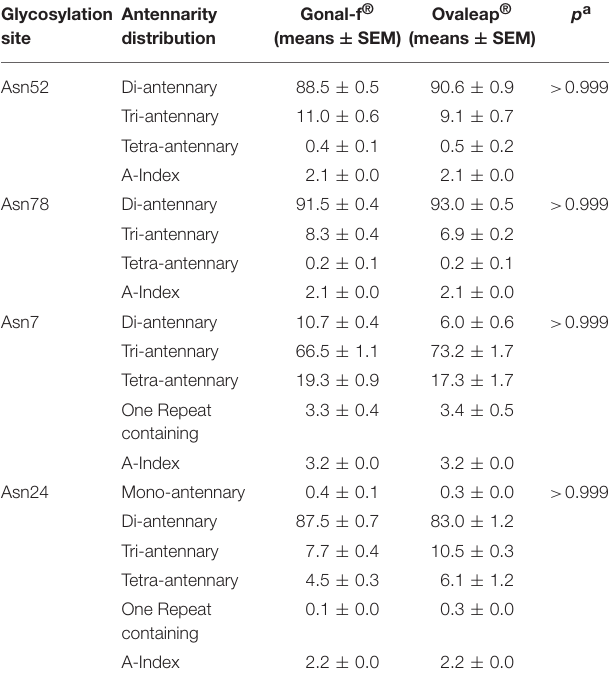
alfa preparations.